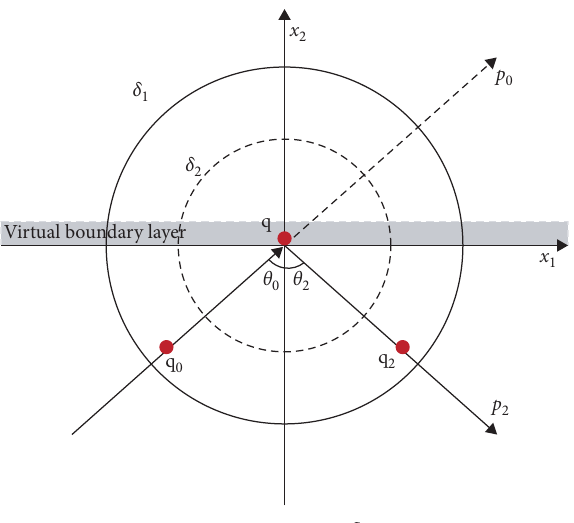
Figure 1: SH wave